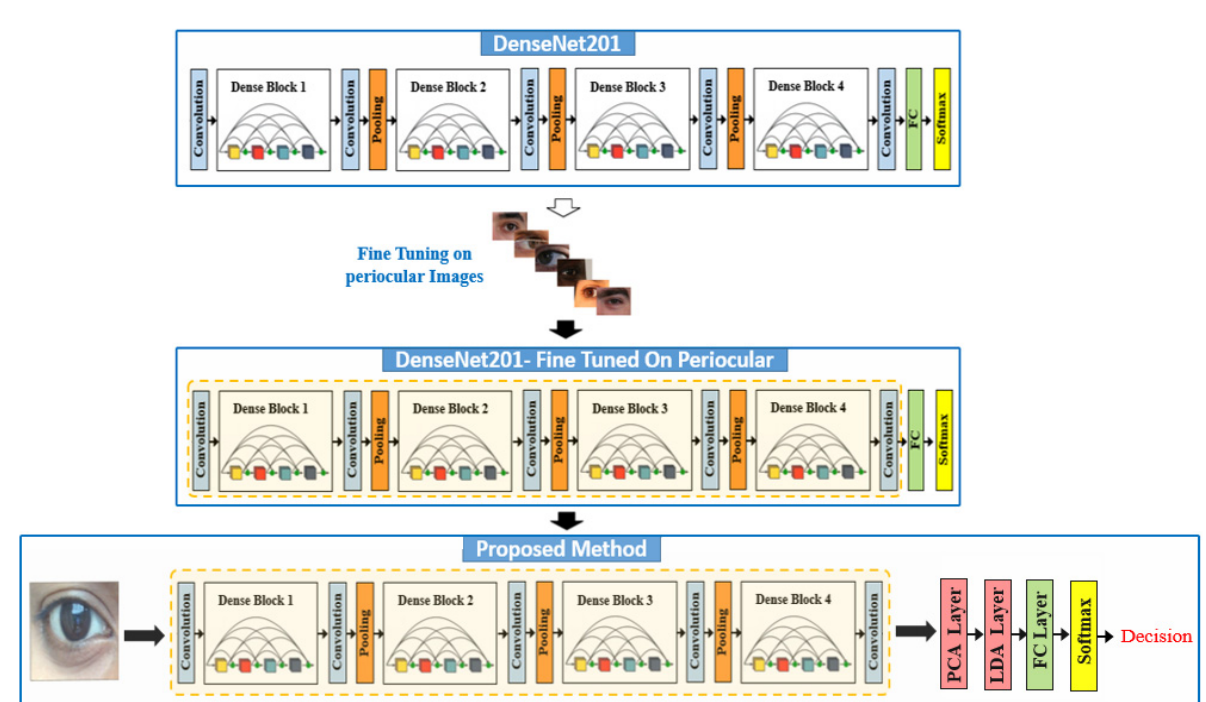
Figure 5. An instance of LDA-CNN model with DenseNet201 as backbone model. Table 1. The internal structure of DenseNet201 CNN model.